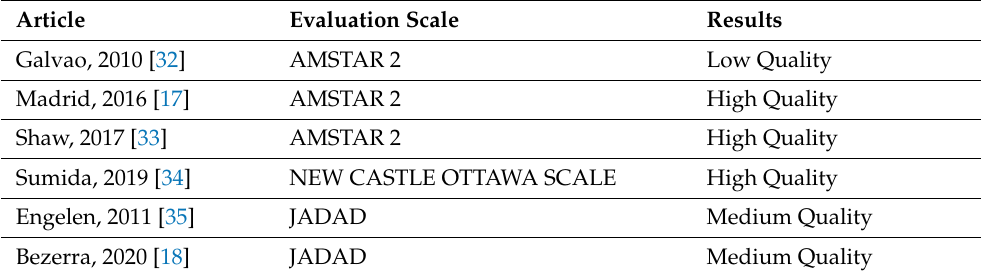
Table 2. Validation of scientific